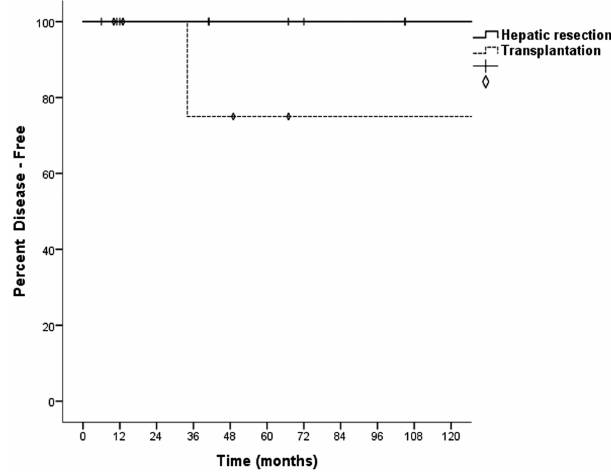
Figure 3. The 5-year disease-free survival curves of patients with liver transplantation versus hepatic